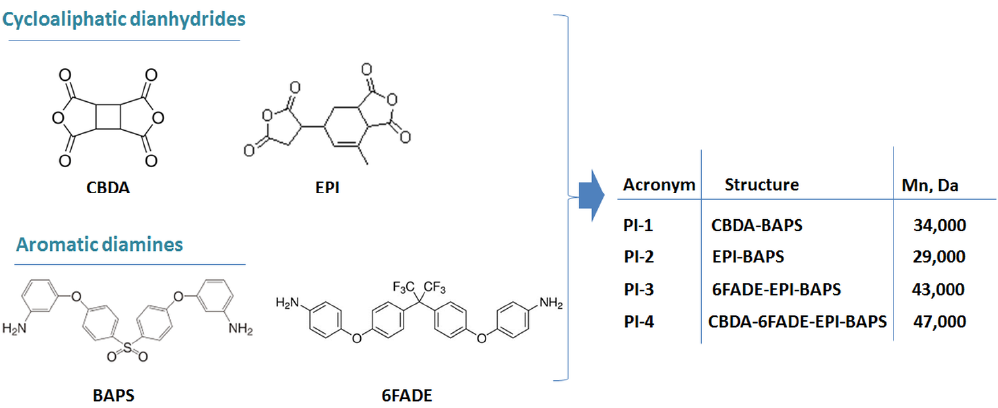
Figure 1. Schematic illustration of the monomer structures. The inserted table contains information on the acronyms, the polyimide structures after the monomer combination, and the number of average molecular weights corresponding to each sample.